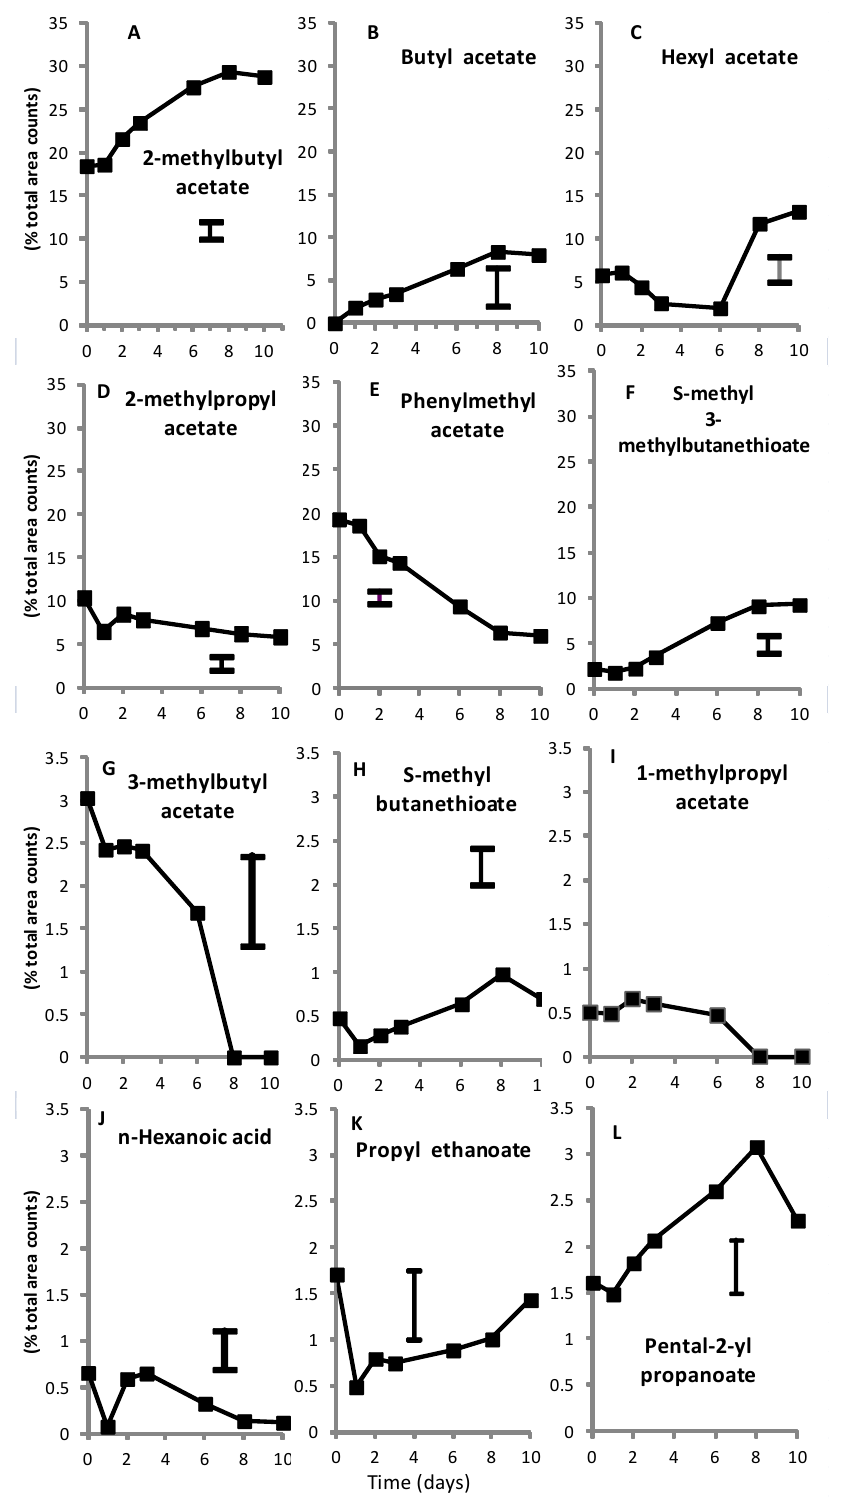
Figure 2. Relative concentration of individual aroma volatiles expressed as mean percentage of total area counts of the compounds identified per chromatogram and obtained by headspace stir-bar sorptive extraction (1 h) during ripening at 21 ± 1 °C and 93% ± 3% relative humidity of intact fruit of the near-isogenic line SC3-5-1 (mean ± SE, n =